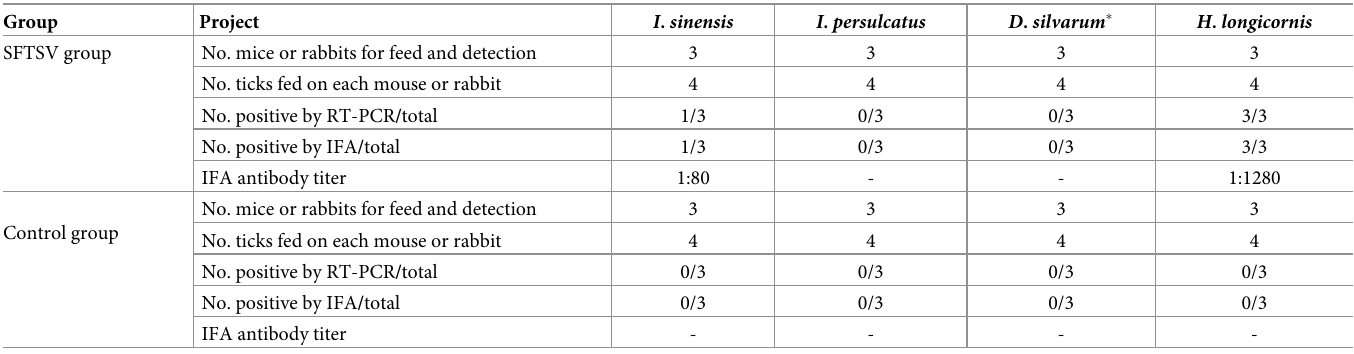
Table 3. Animals used in the transovarial transmission cycle of SFTSV for four tick species. Group